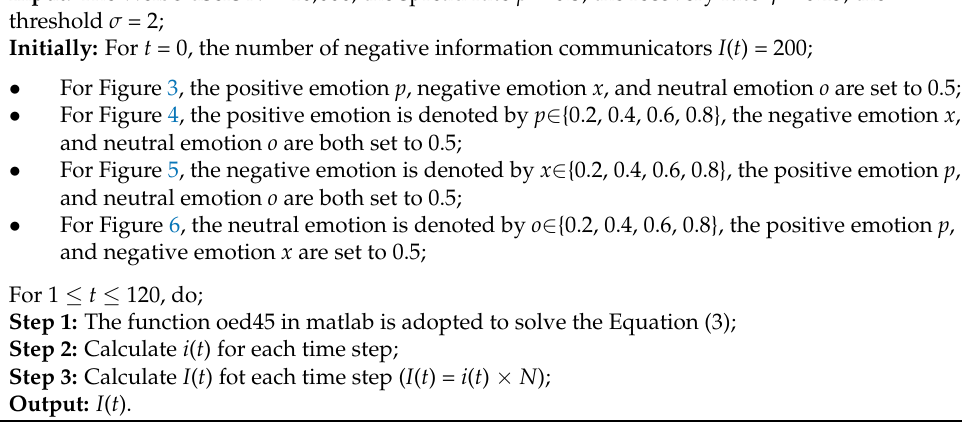
Table 2. The detailed steps of the simulation analysis using MATLAB.